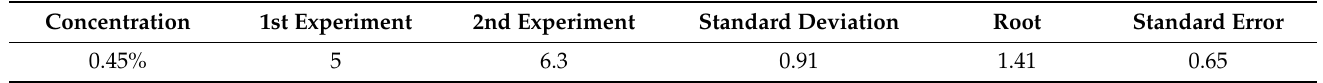
Table 2. Initial calculation for standard deviation and standard